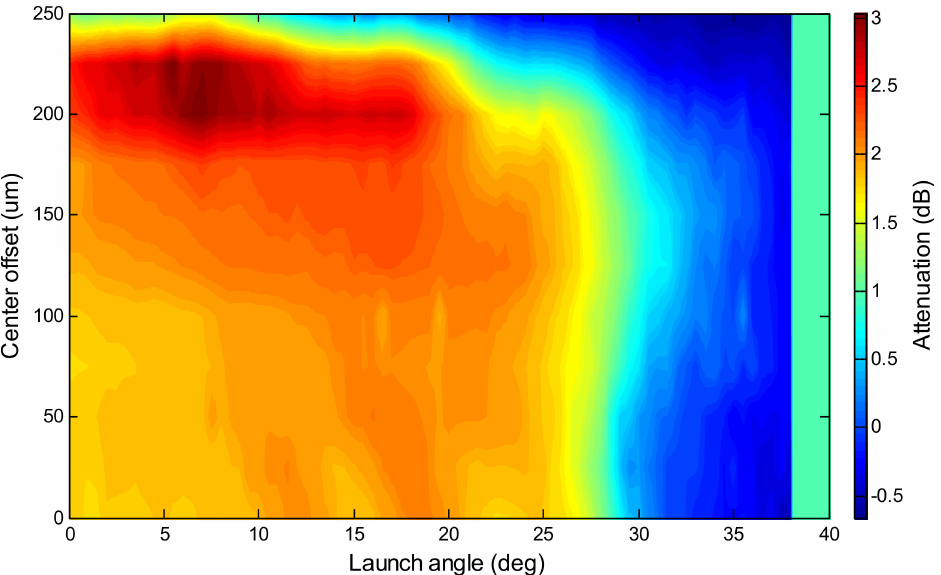
Figure 12. Attenuation (color depth) induced by 0.1 ng / mL concentration Rhodamine B relative to pure water as a function of launch angle and center o ff set. Reprinted with permission from [64]. Copyright (2019) American Chemical